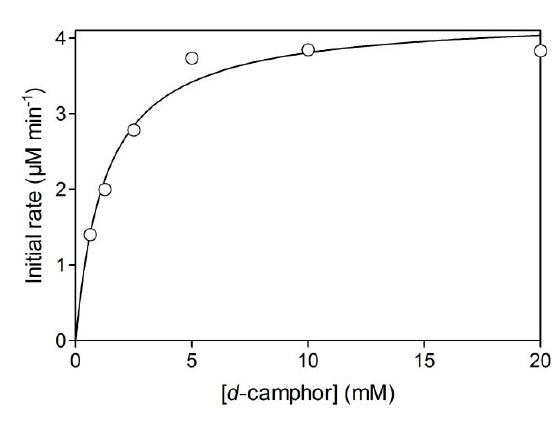
Figure 3. Relationship between initial rate of NADH oxidation and the concentration of d - camphor at a W of 17. The reaction mixture contained 0.05 μ M branched P450cam and 0 80 μ M NADH.